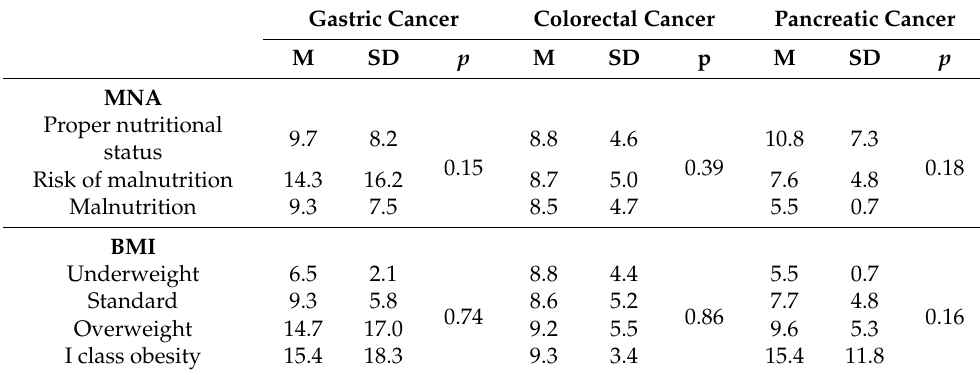
Table 5. Relationship between the nutritional status of the respondents before surgery and the length of hospitalization, taking into account the type of cancer. Gastric Cancer Colorectal Cancer Pancreatic